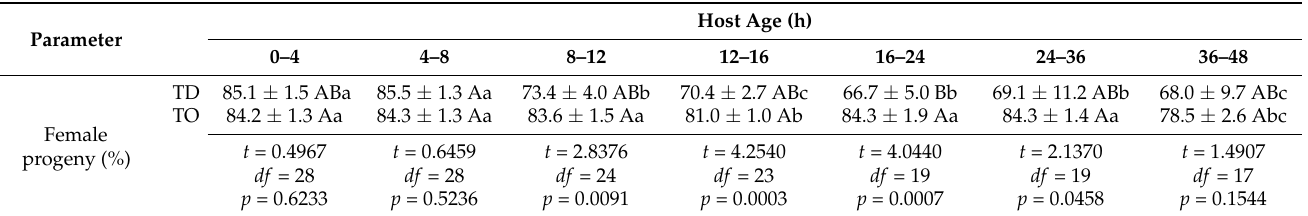
Table 4. Female progeny (%) of Trichogramma dendrolimi (TD) and Trichogramma ostriniae (TO) on Asian corn borer (ACB) of different